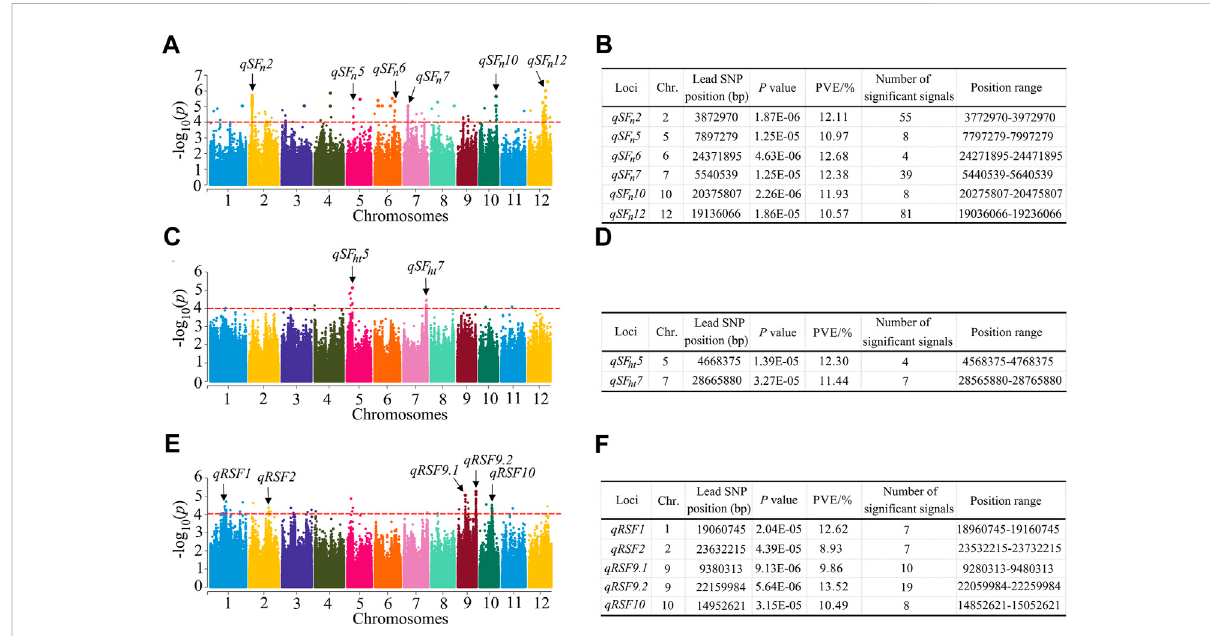
FIGURE 3 Identi fi cation of QTLs by GWAS in rice. (A) Manhattan plots for SF n in the whole population of rice accessions. (B) Information of the identi fi ed QTLforSF n . (C) ManhattanplotsforSF ht inthewholepopulationofriceaccessions. (D) Informationoftheidenti fi edQTLforSF ht . (E) Manhattanplots forRSFinthewholepopulationofriceaccessions. (F) Informationoftheidenti fi edQTLforRSF. Y axismeansnegativelog 10 transformed p -valuesand dots abovethe redline show thesigni fi cant SNPs in theQTLregion.The black arrowsindicate theQTL identi fi ed.SF n , spikelet fertilityin normal condition; SF ht , spikelet fertility in high temperature condition; RSF, relative spikelet fertility. PVE: phenotypic variation